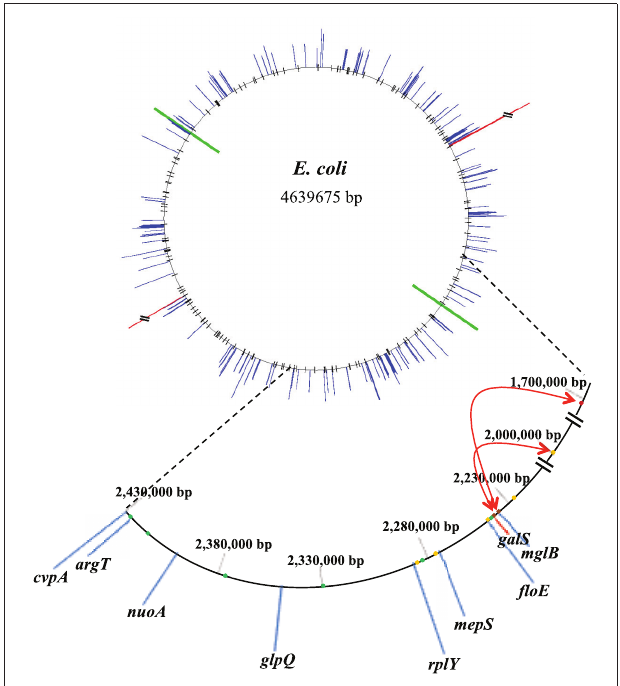
FIGURE 7 | Correlation of GalR operator locations and change in transcription pattern in the absence of GalR relative to in the wild type E. coli in the bacterial genome. The ori and ter of replication are shown by green lines. Blue lines indicate the extent of down-regulated genes while red lines indicate the extent of up-regulated genes. The 165 GalR operators, demonstrable or potential, are shown as black lines in the top part. In the enlarged part (from 1.7 to 2.43 Mb), the extent of down-regulated and up-regulated genes are shown in blue and red lines, respectively. The dots represent some of the GalR operators. GRS and CAS are shown as green and orange dots, respectively while brown dots indicate that the binding sites serve as both GRS and CAS. The red arrows display the interactions between GalR operators detected by 3C